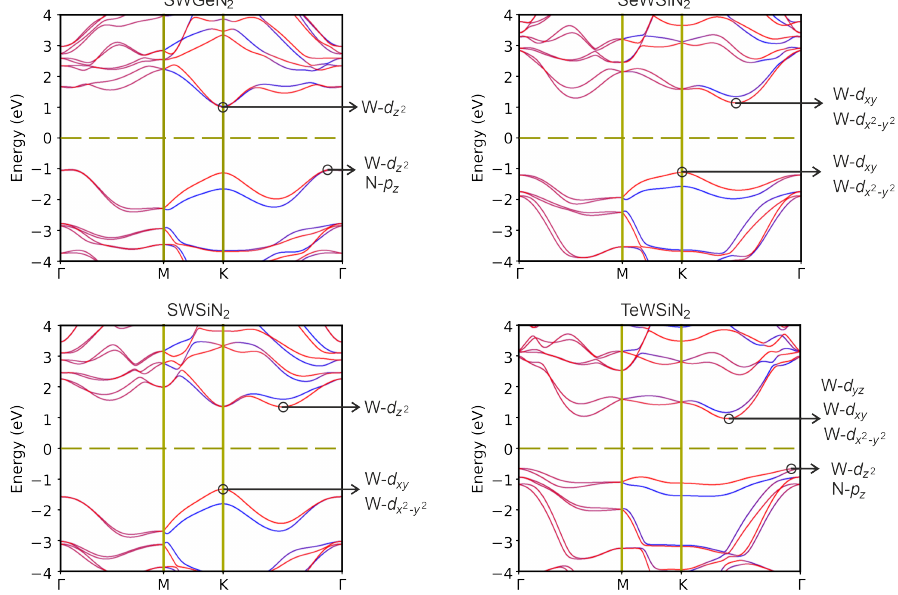
Figure 5. Band structures XMoSiN 2 (X = S, Se, Te) calculated using HSE06+SOC. Inserts indicate the states forming VBM and CBM. Table 2. Bandgap E g calculated using PBE, HSE06, and HSE06+SOC functionals, SOC splitting ∆ V for valence band maximum and ∆ C for conduction band minimum, potential energy difference δφ and dipole moment µ in Janus structures X-W-AN 2 (X = S, Se, Te; A = Si,